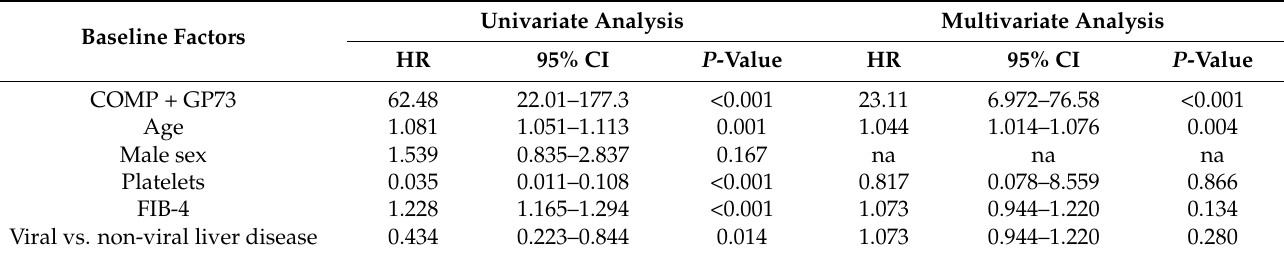
Table 4. Baseline factors associated with liver-related